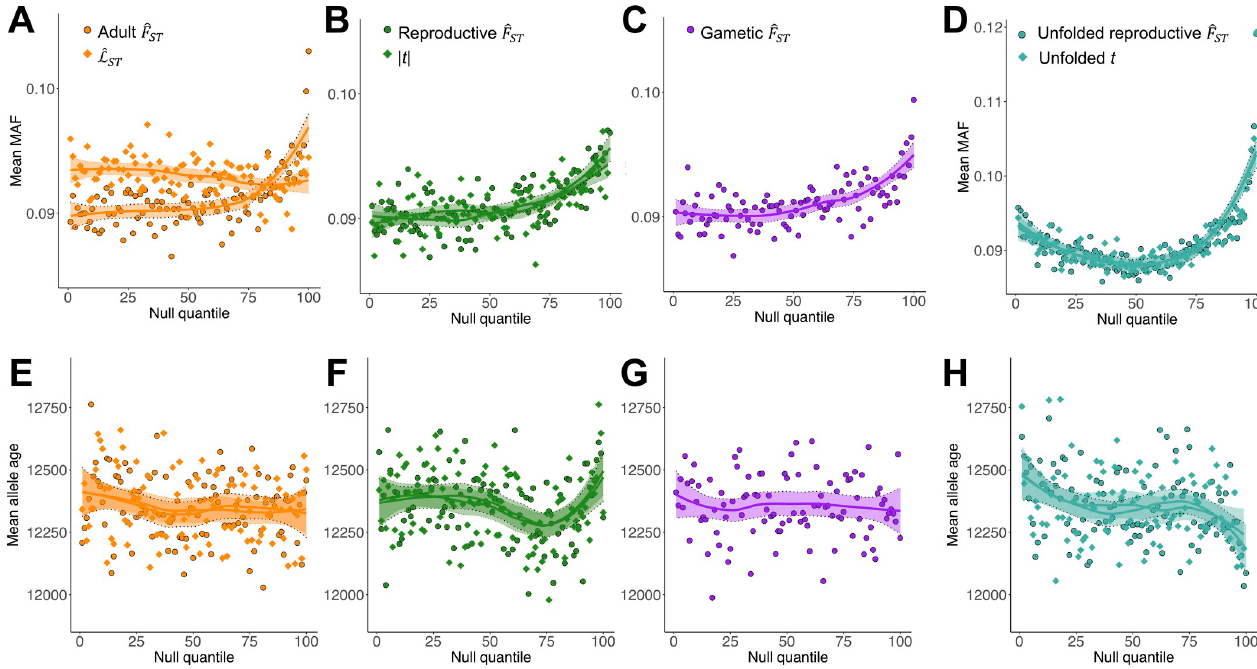
Fig 6. Modes of evolution of sex-differentiated sites. ( A–D ) Mean MAF, in the UK Biobank, across 100 quantiles of the null for each metric of sex-differential metrics, x -axes correspond to Fig 2A–2C (and Fig 3B for unfolded reproductive ^ F ). For mixed-model metrics, x -axes correspond to Fig selection. For ^ F ST ST 4A–4C. LOESS curves ( ± SE) are presented for visual emphasis. ( E-H ) Mean age of the alternative (i.e., non-reference) allele across 100 quantiles of the null for each metric of sex-differential selection. Each panel corrects for ascertainment bias of allele frequencies among highly sex-differentiated sites (i.e., Fig 6A–6D). For visualisation purposes, this was done by averaging, in each quantile, allele age across 20 quantiles of alternative allele frequency in the UK Biobank (such that UK Biobank alternative allele frequency is approximately equal across quantiles). LOESS curves ( ± SE) are presented for visual emphasis. The code and data needed to generate this figure can be found at https://github.com/filipluca/polygenic_SA_selection_in_the_UK_biobank and https://zenodo.org/record/